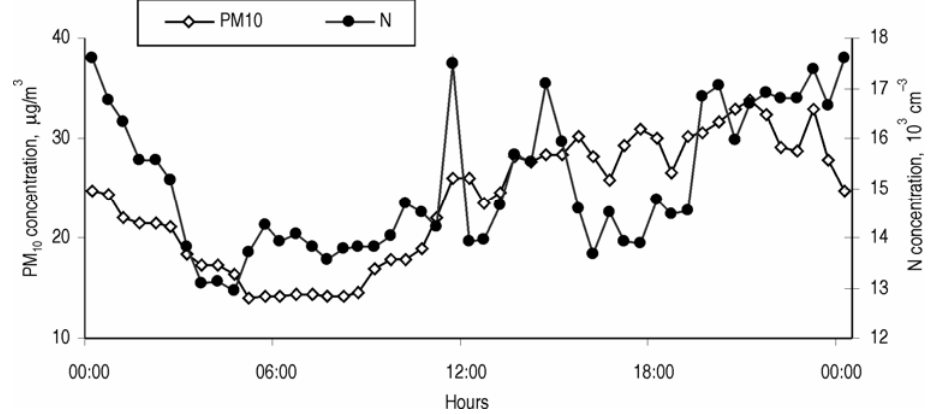
Fig 8 . Average daily variation of aerosol number (N) and PM 10 mass concentrations on 14–24 October 2005